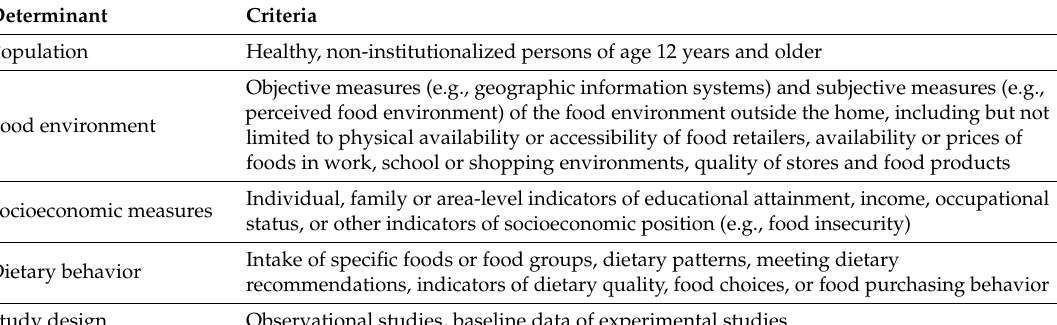
Table 1. Inclusion